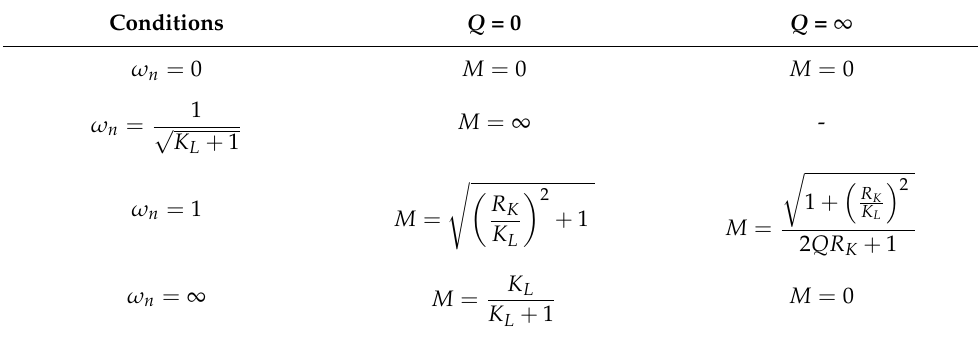
Table 1. DC voltage gain M of converter according to each normalized frequency ω n .